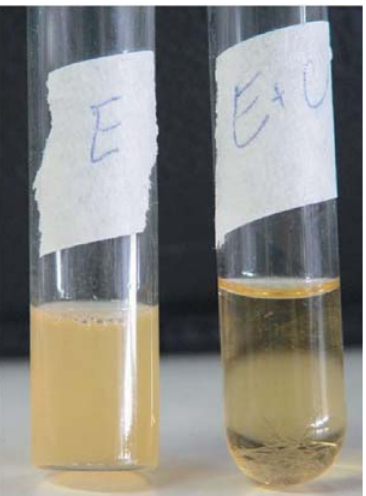
Figure 4- Results of bacterial growth in individual test tube. group I (E) and group IV (E+U)